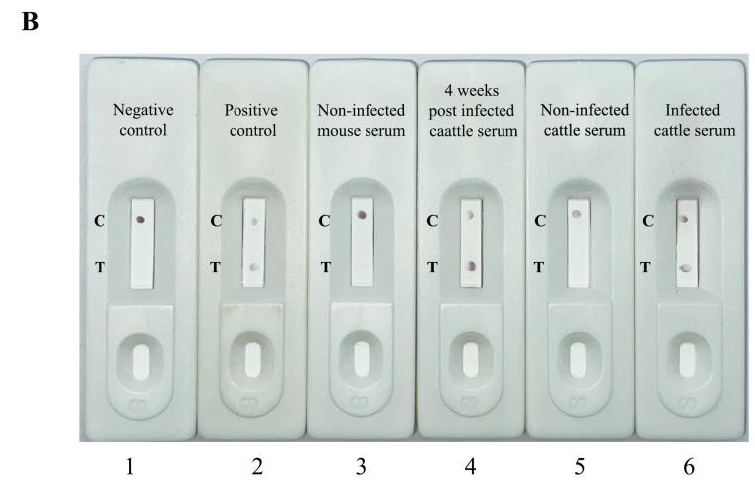
Figure 5. ( A ) Schematic illustration result of colloidal gold test strip. (1A and 2A) Positive test, (3A) negative test, and (4A and 5A) invalid. ( B ) Representative photos of rapid antibody detection assay.